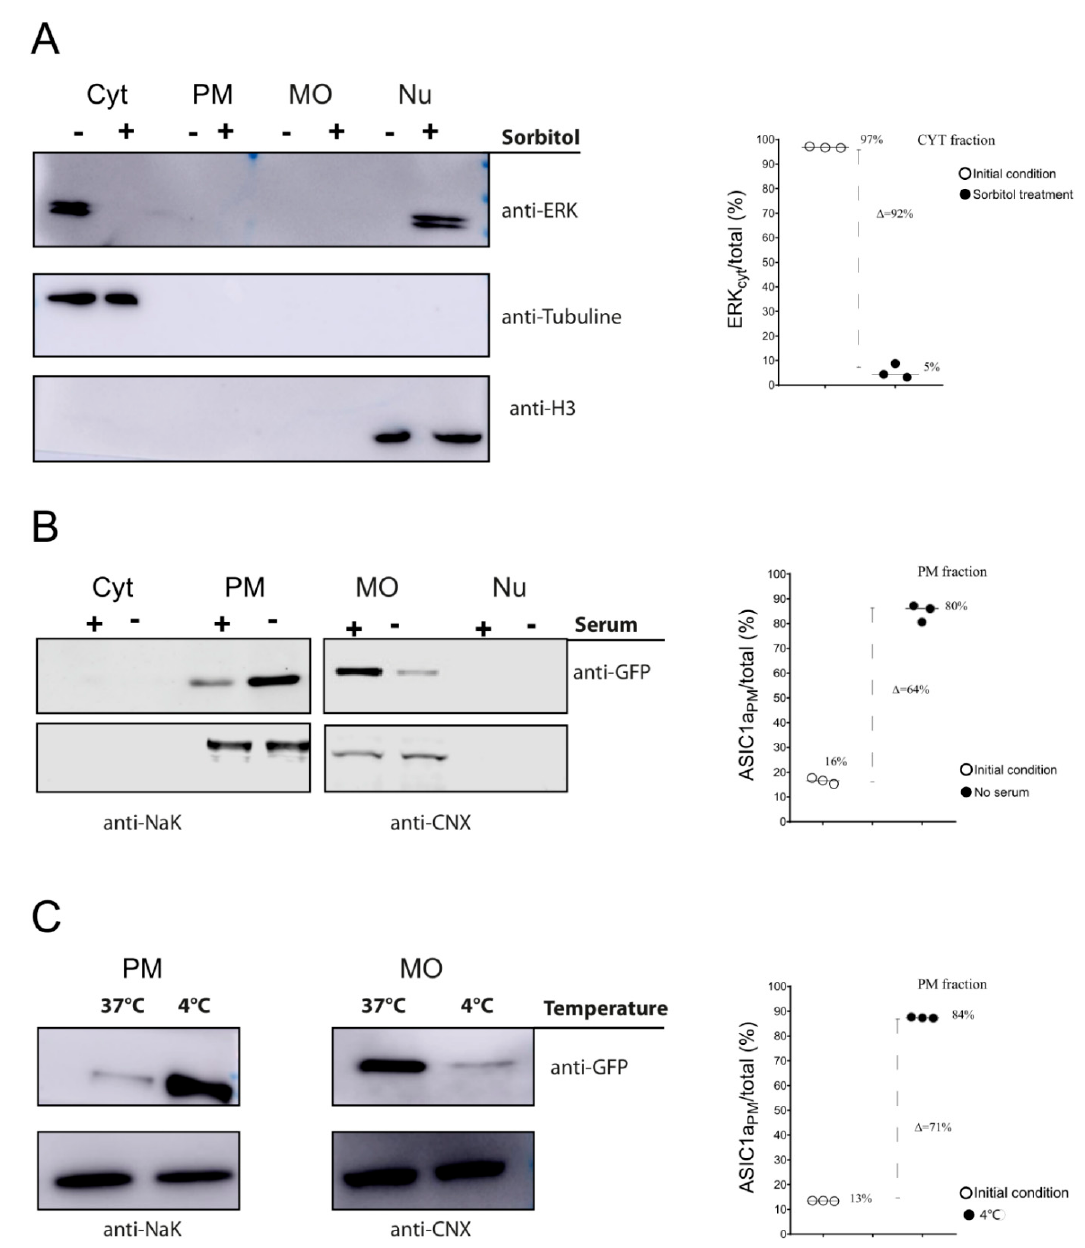
Figure 4. Fractionation to detect changes in protein distribution. ( A ) Representative WB membranes of HEK293 cell lysates obtained by the fractionation method to detect total ERK protein in the different fractions (Cyt, PM, MO, Nu) in control ( − ) or sorbitol-treated (+) cells using an anti-total ERK antibody with tubulin as a cytosolic marker or histone as a nuclear marker. Plot showing the percent changes of fractions for both conditions. ( B , C ) Representative Western blots of eGFP-ASIC1a- HEK293-expressing cell lysates obtained by our fractionation method to detect eGFP-ASIC1a protein in MO and Nu fractions exposed to either a 120 min medium without serum incubation, as opposed to the normal (+ serum) incubation, ( B ) or a 20 min 4 ◦ C incubation, as opposed to the normal 37 ◦ C incubation ( C ); to the right, plots showing changes in the percent fractions for either